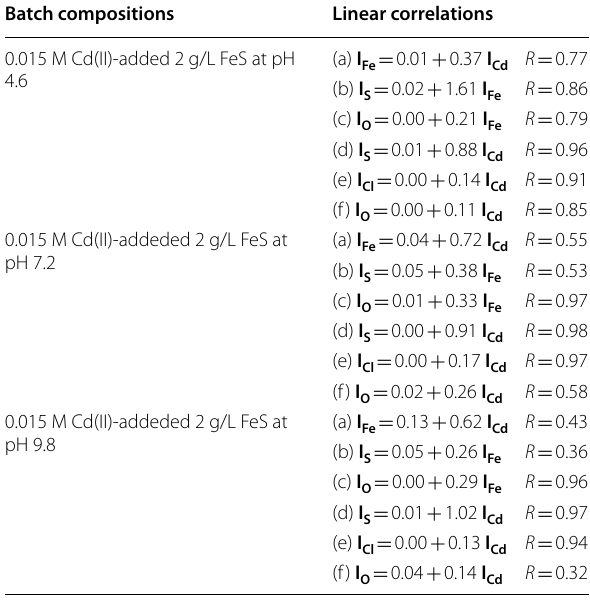
Table 1 Spatial correlation analyses of dispersive